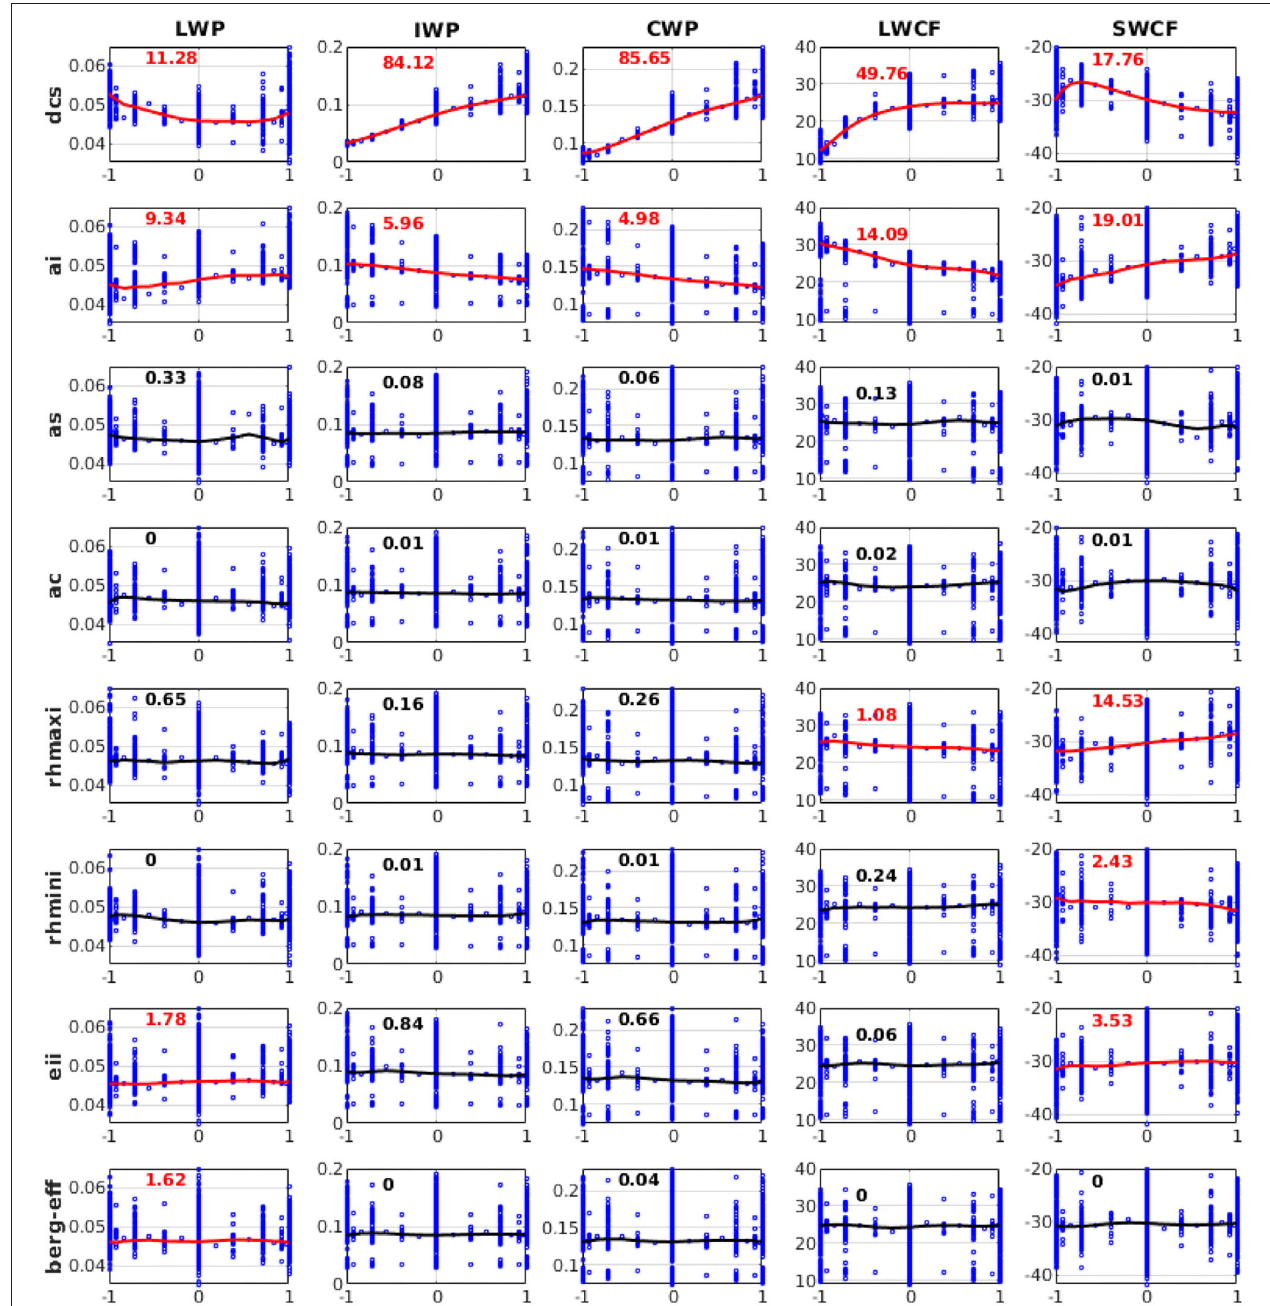
FIGURE 8 | Variation of liquid water path (LWP), ice water path (IWP), cloud water path (CWP), longwave cloud radiative effect (LWCF), and shortwave cloud radiative effect (SWCF) in response to perturbations of eight different parameters from 3,937 SCAM6 simulations. The numbers in each plot represent the relative contributions (in %) of each input parameter perturbation to the overall variation of different variables. Red indicates that the contribution is significant ( F -test) at the 95% significance level. The line in each plot corresponds to the response effect of the perturbation of a single parameter when all other parameters at maintained at the zero (central) position of their uncertainty range for the simulation of that variable. Vertical bars denote the range of variation in values of a particular variable in response to the perturbation of other parameters.